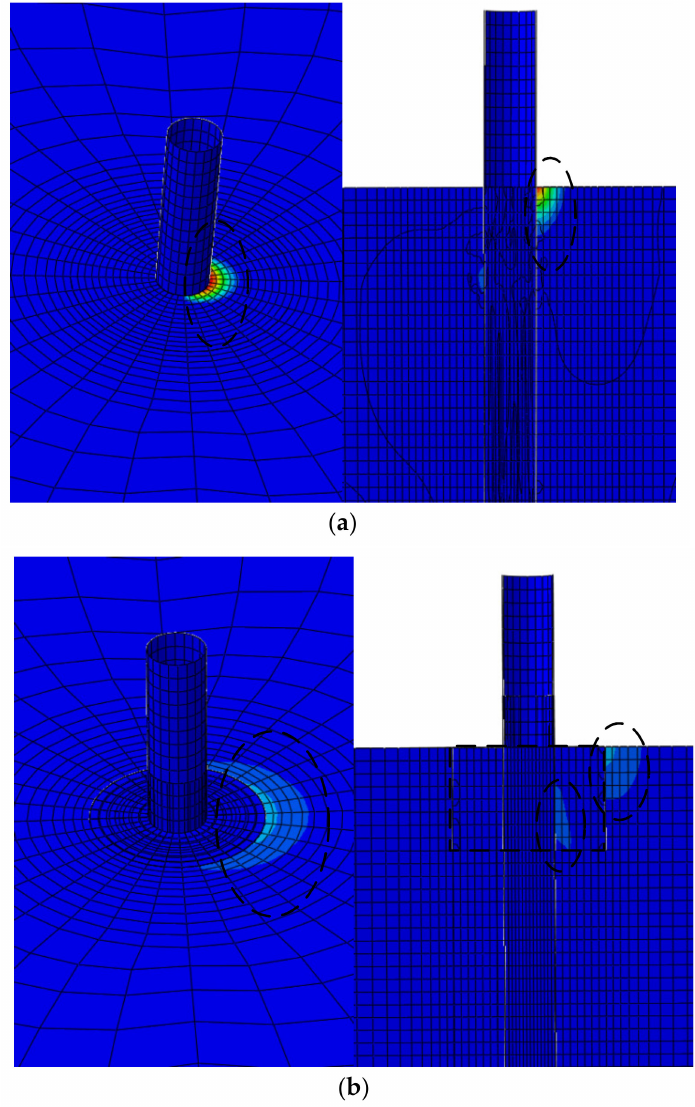
Figure 8. Plastic area distribution. ( a ) Monopile foundation. ( b ) Pile–bucket